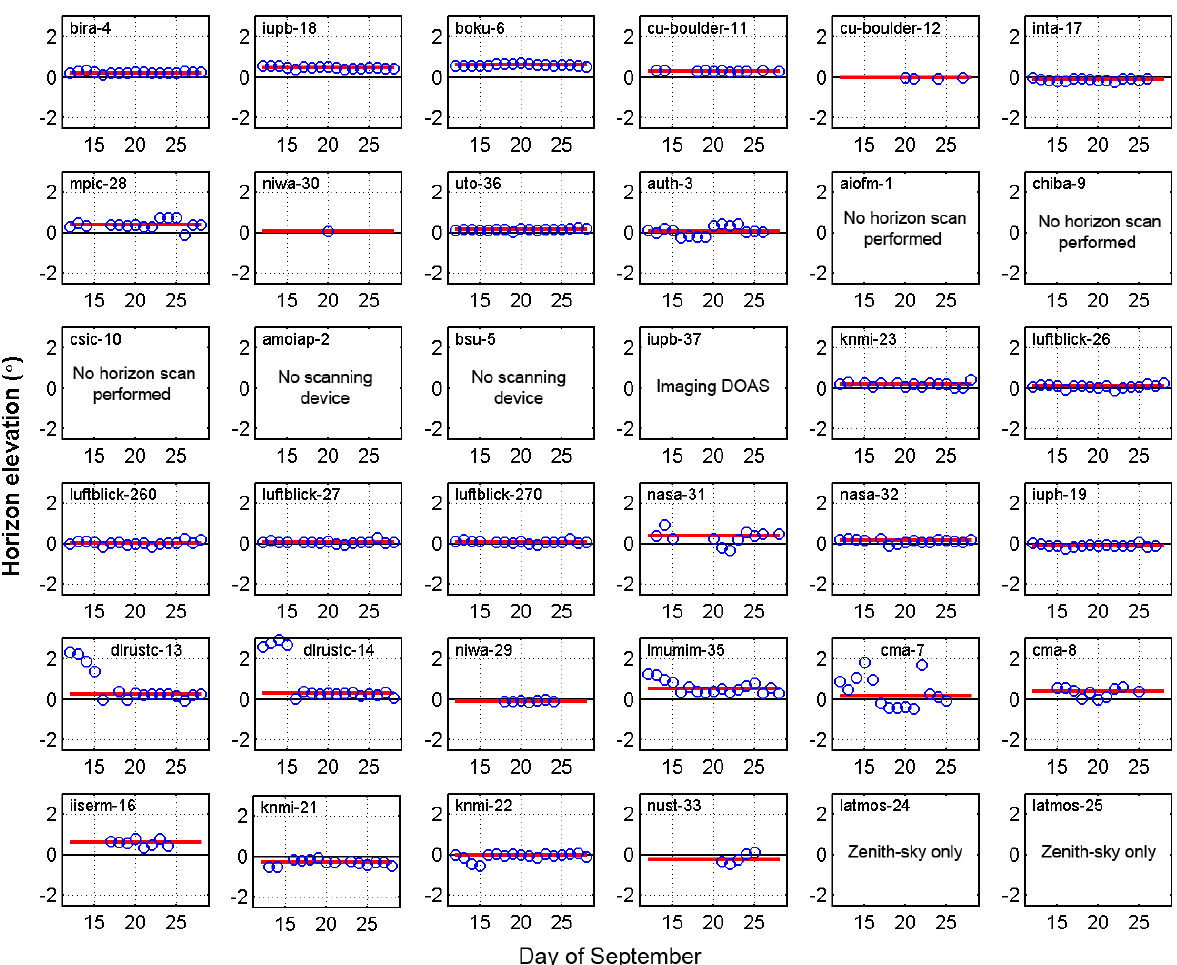
Figure 5. Time series of horizon elevation values (blue circles) derived from daily horizon scans performed with each instrument during the intercomparison period in the visible wavelength range (except for knmi-21). When no data are available for the horizon scan analysis, a short explanation is given. The red lines indicate the median